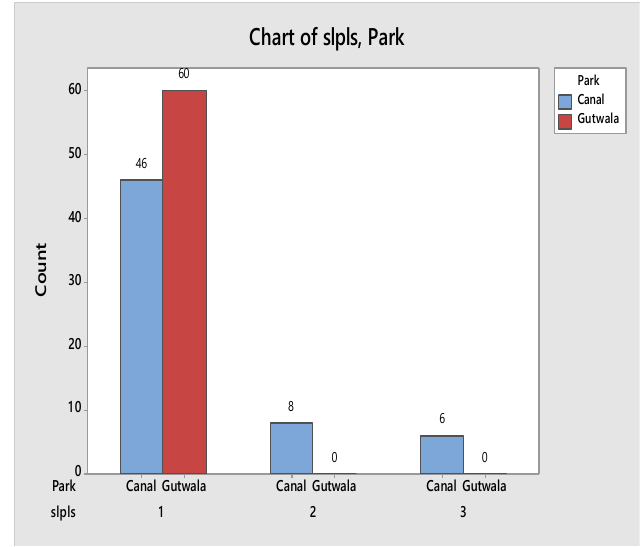
Figure 10: Bar Chart of Communication problem between both sites It is clearly indicated in the fig.10 that 58 out of 60 visitors responded highly affected by the communication problem (interference) due to noise contrarily, all sampled 60 visitors in the Site-2 Gat Wala Park did not show any interference due to noise pollution, which mean mostly response observed in this regard was nil (communication Problem). Figure 11: Bar Chart of Stress problem between both sites 5 out of 60 visitors responded highly affected by the stress due to noise